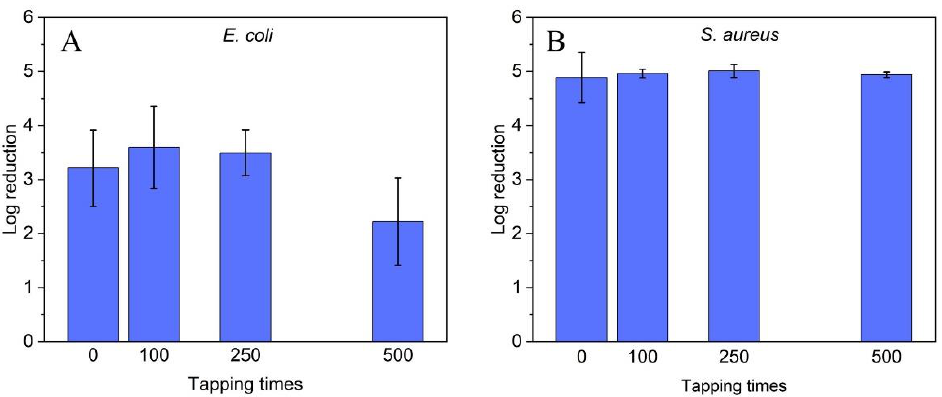
Figure 5. Antibacterial efficacy of ZnO coated surfaces after extensive use against ( A ) E. coli and ( B ) S. aureus . Standard deviation represents the average of three individual